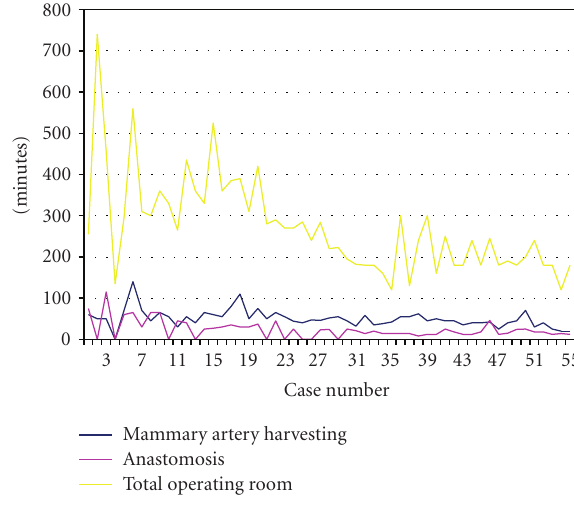
Figure 1: Operative time learning